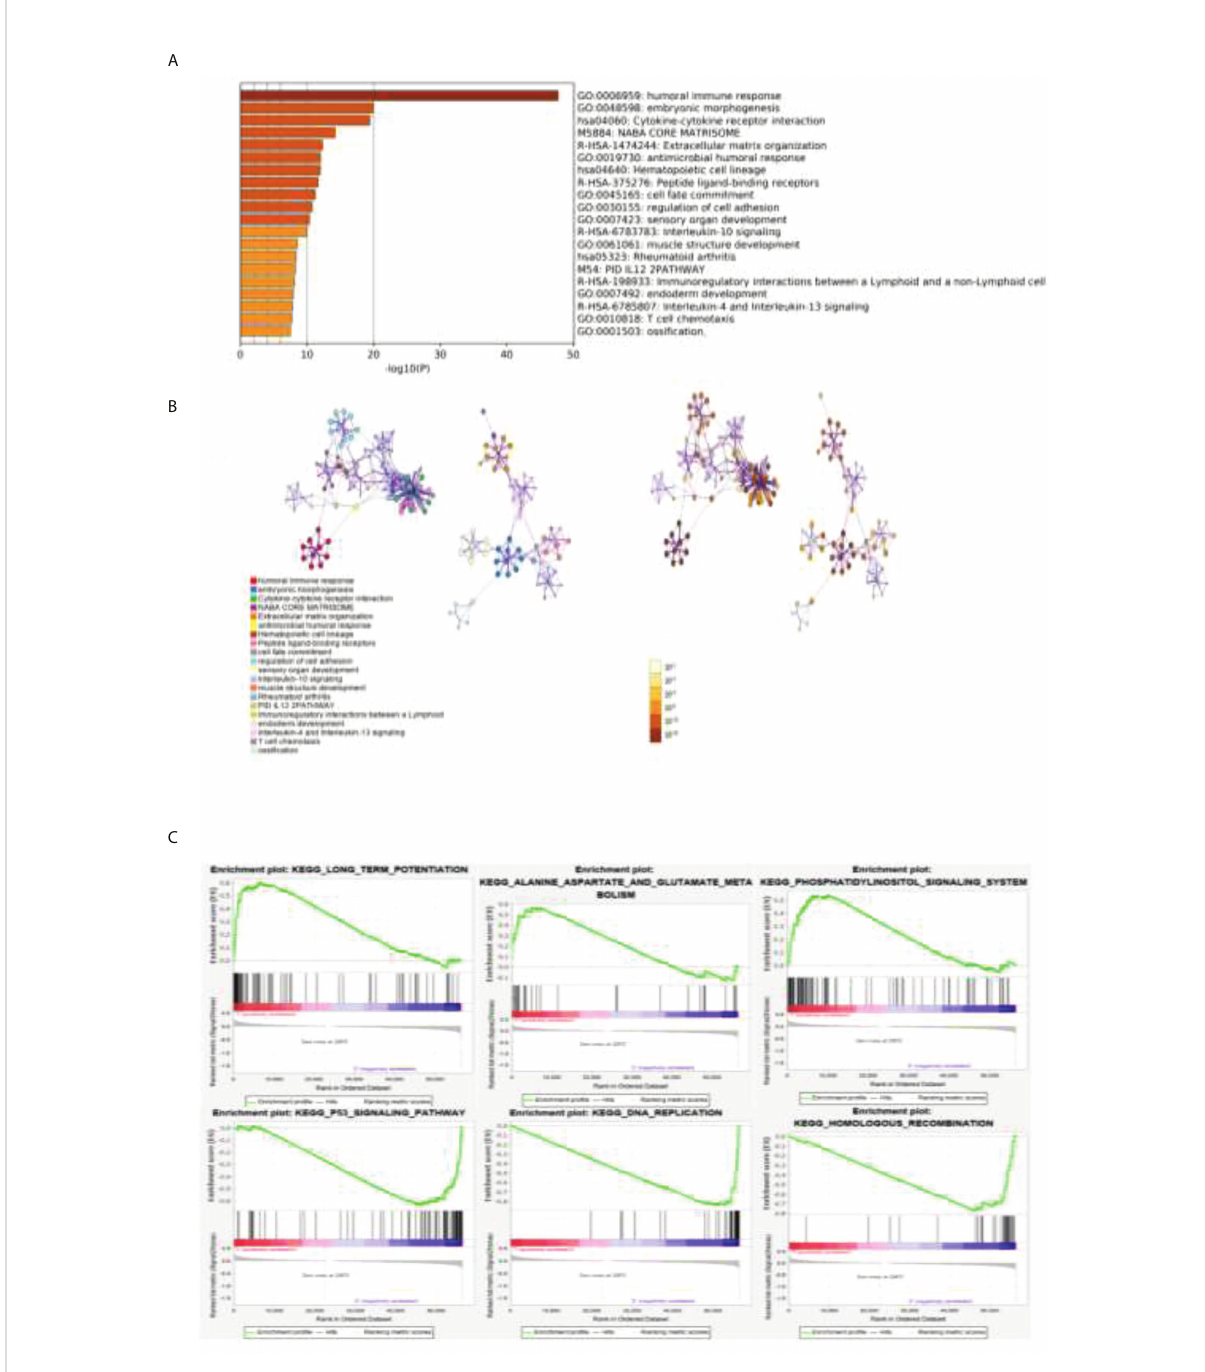
FIGURE 4 GO and KEGG analyses of related gene pathways. (A) DEGs about related gene pathways. (B) Further pathway analysis was performed by using Metascape. Each point in a pathway represents a gene. The aggregation of different color points in the left panel represents its enriched pathway, and the different color depth in the right panel represents the p-value of a different enriched pathway. (C) The top three pathways enriched in both clusters 1 and 2 were analyzed by GSEA enrichment